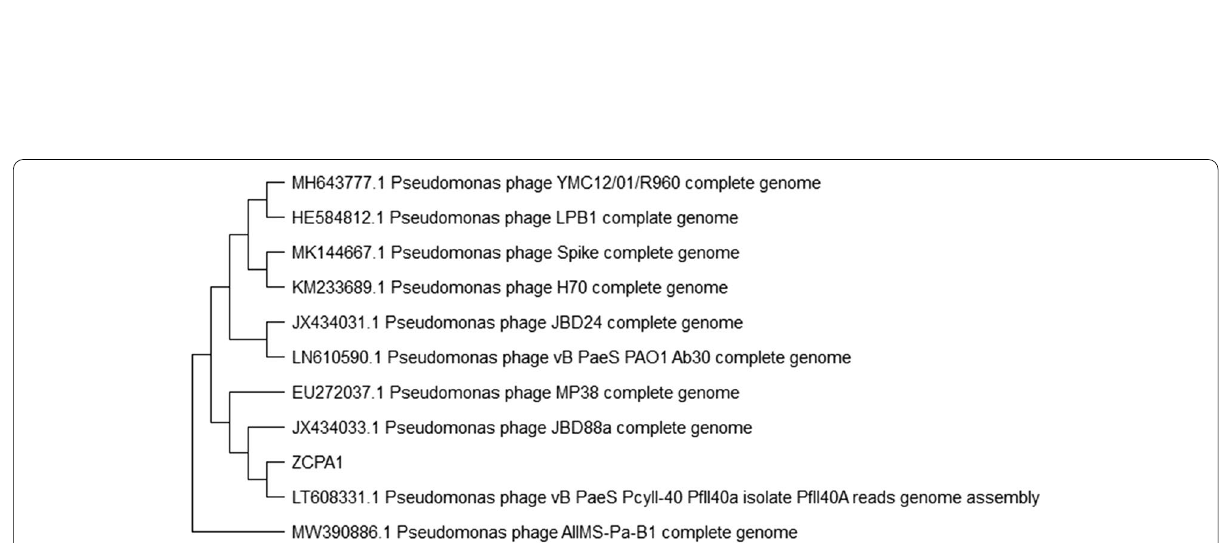
Fig. 2 The physical stability of the phage ZCPA1. A Phage viability at different temperatures, B phage viability at different pH values, and C phage viability under UV light ( λ